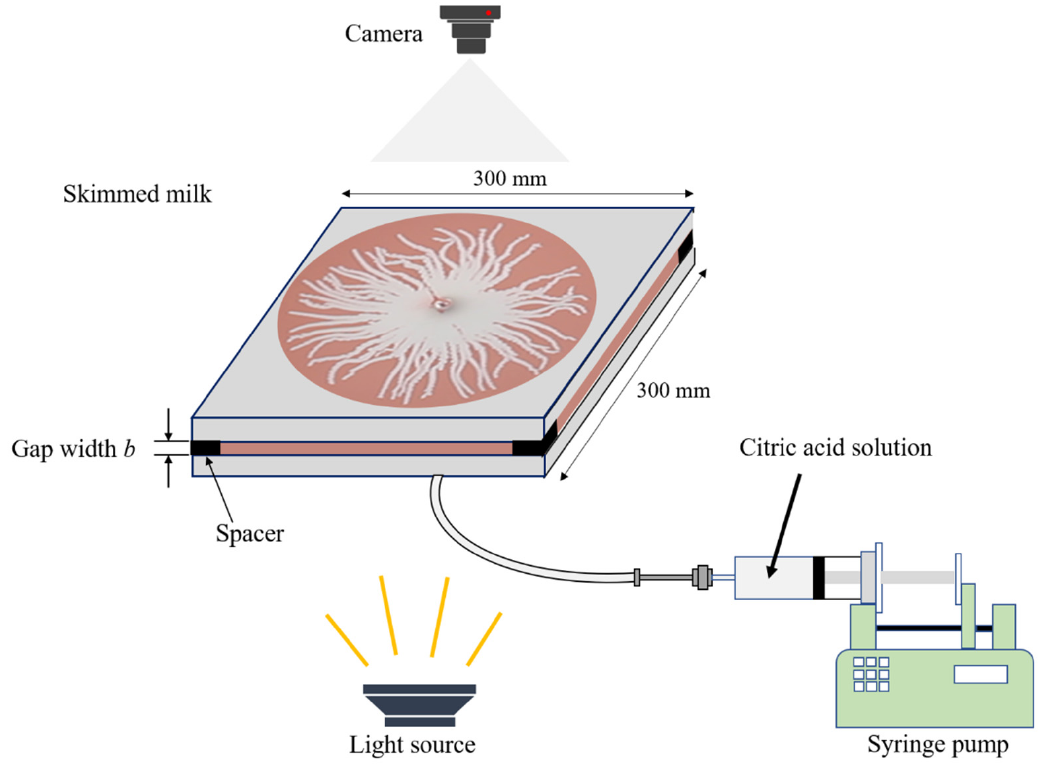
Figure 1. Schematic diagram of the experimental setup.